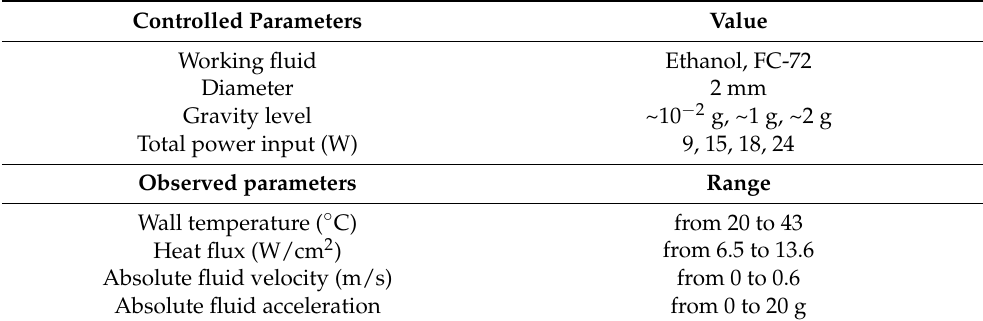
Table 3. Experimental matrix with controlled parameters and parameters